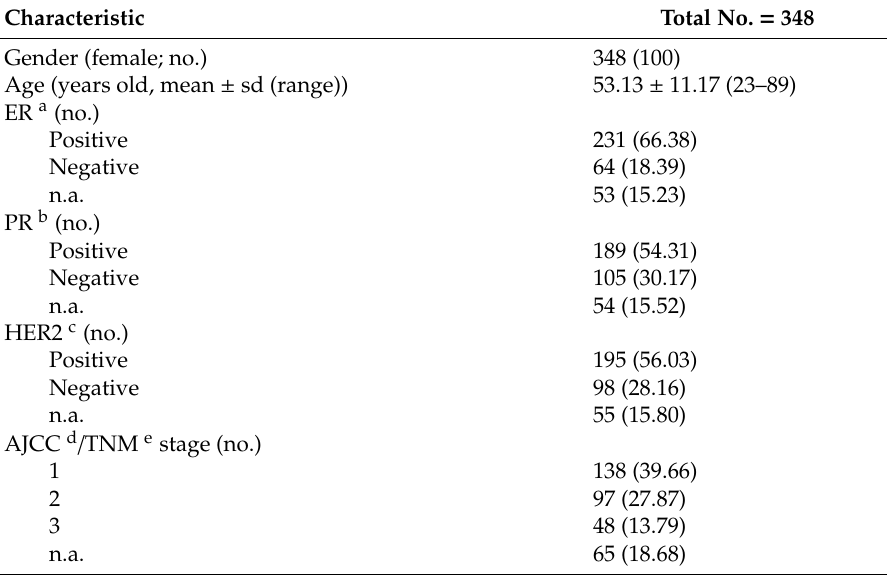
Table 1. Basal characteristics of Taiwanese breast cancer (BC) patients.